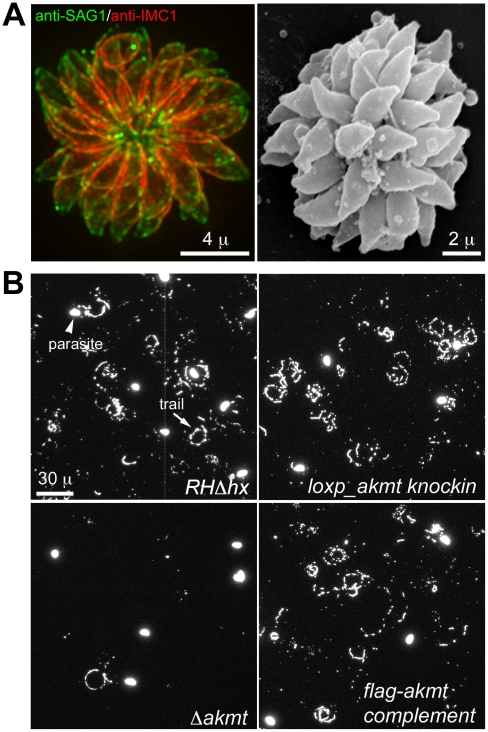
The motility of Δakmt parasites is impaired.(A) “Extracellular rosettes” found in Δakmt parasite culture. Left: Fluorescence image of a Δakmt extracellular rosette, a cluster of parasites remaining attached to each other after host cell breakdown. Green: anti-SAG1; red: anti-IMC1. Right: Scanning electron microscopy image of a Δakmt extracellular rosette. (B) Trail assays of RHΔhx, loxp_akmt knockin, Δakmt and flag-akmt complement parasites, showing that there is a marked decrease in trail deposition in Δakmt parasites compared to the parental and complemented lines. Mouse anti-SAG1 antibody and goat anti-mouse Alexa488 were used to visualize trails (arrow) deposited by the parasites.